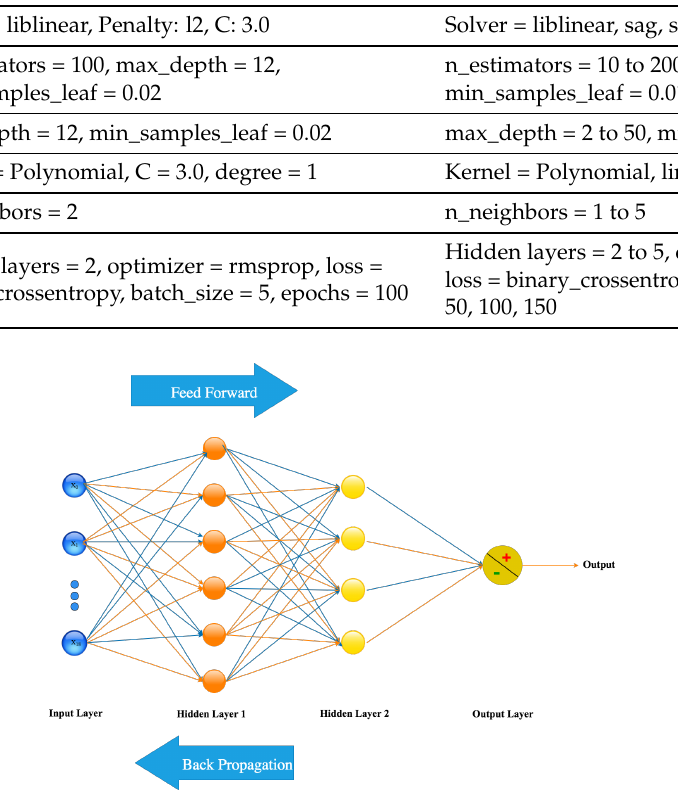
Figure 6. Diagram presenting the final architecture of